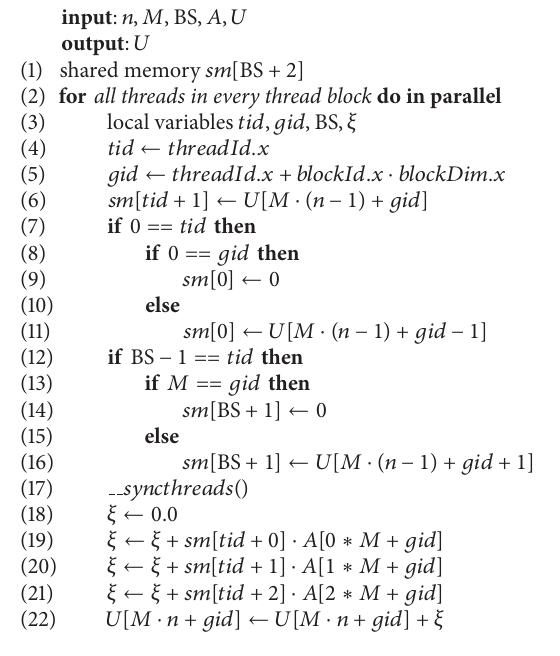
Algorithm 2. Algorithm 2 computes 𝑈 𝑐𝑜𝑙𝑂𝑢𝑡 + 𝑎 2 𝑈 𝑐𝑜𝑙𝐼𝑛 and